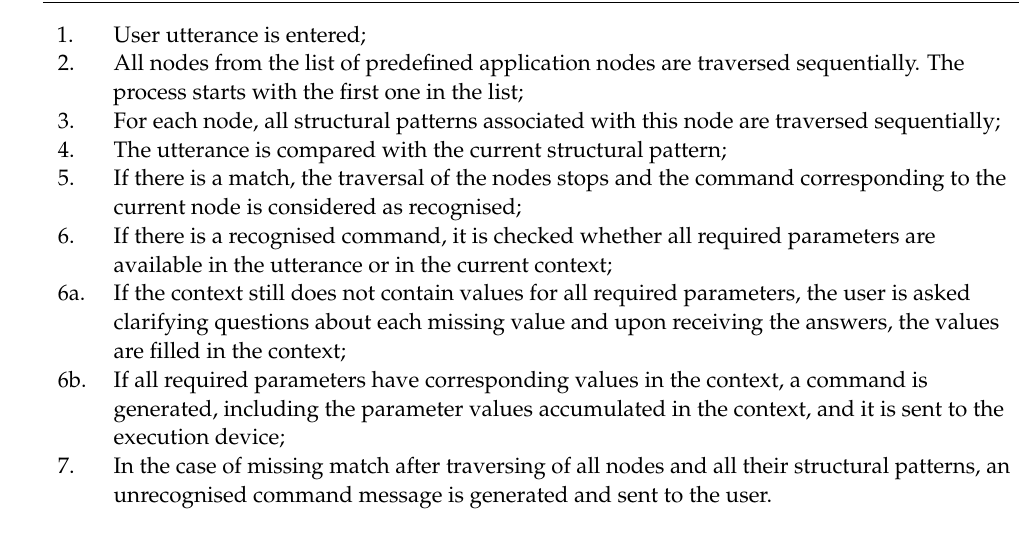
Figure 3. Flowchart of intent-based voice command recognition. Algorithm 2 Intent-based voice command detection from user utterance